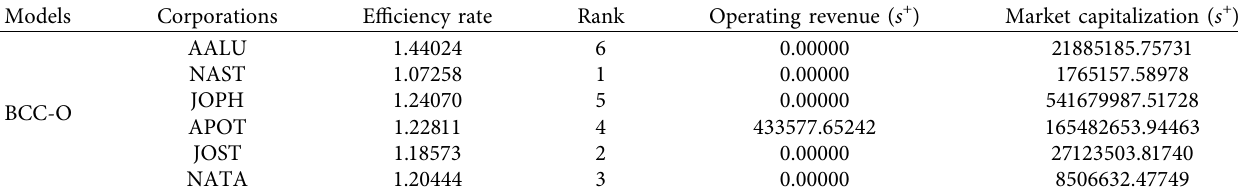
Table 8: The average slacks for output-oriented in BCC models during 2000–2020.